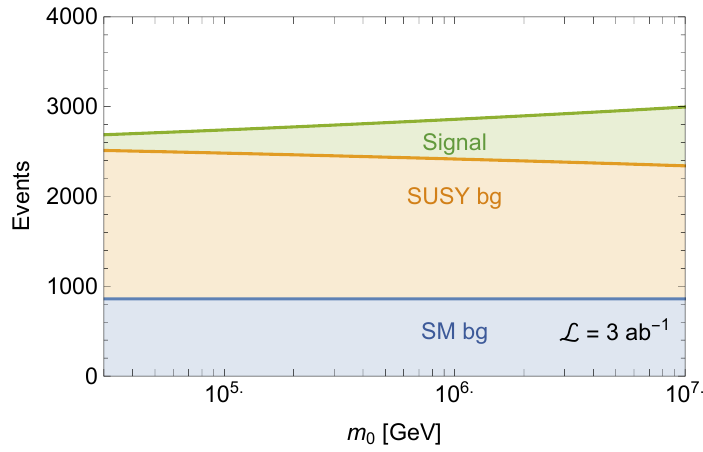
Figure 9 . Stacked number of events passing our cuts at 3 ab (cid:0) 1 for the signal and background as a function of m 0 . We de(cid:12)ne the signal as events with at least one two-body decaying gluino. Events with two three-body decaying gluinos are SUSY backgrounds. The SM background mainly consists of ZZ + jets and t (cid:22) t + Z production. We use NLO production cross sections for the signal [11] and background [8].